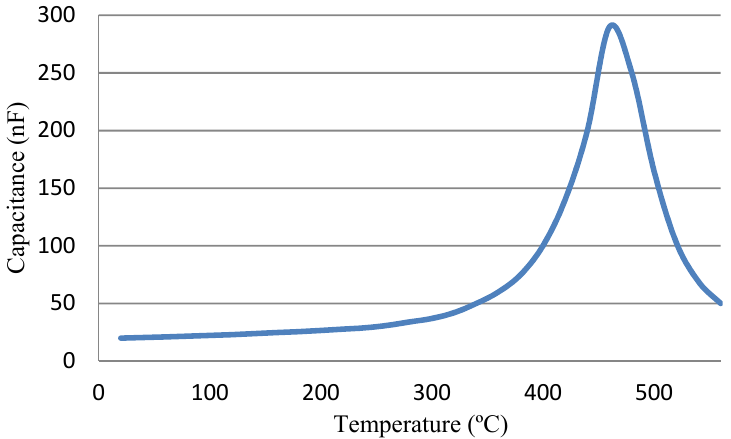
Figure 9. Capacitance value of the high temperature X7R type